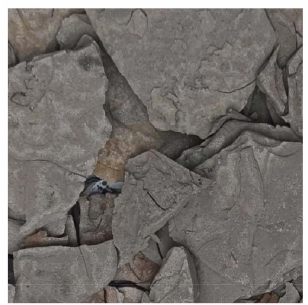
Figure 12. Reticulate tiny cracks.